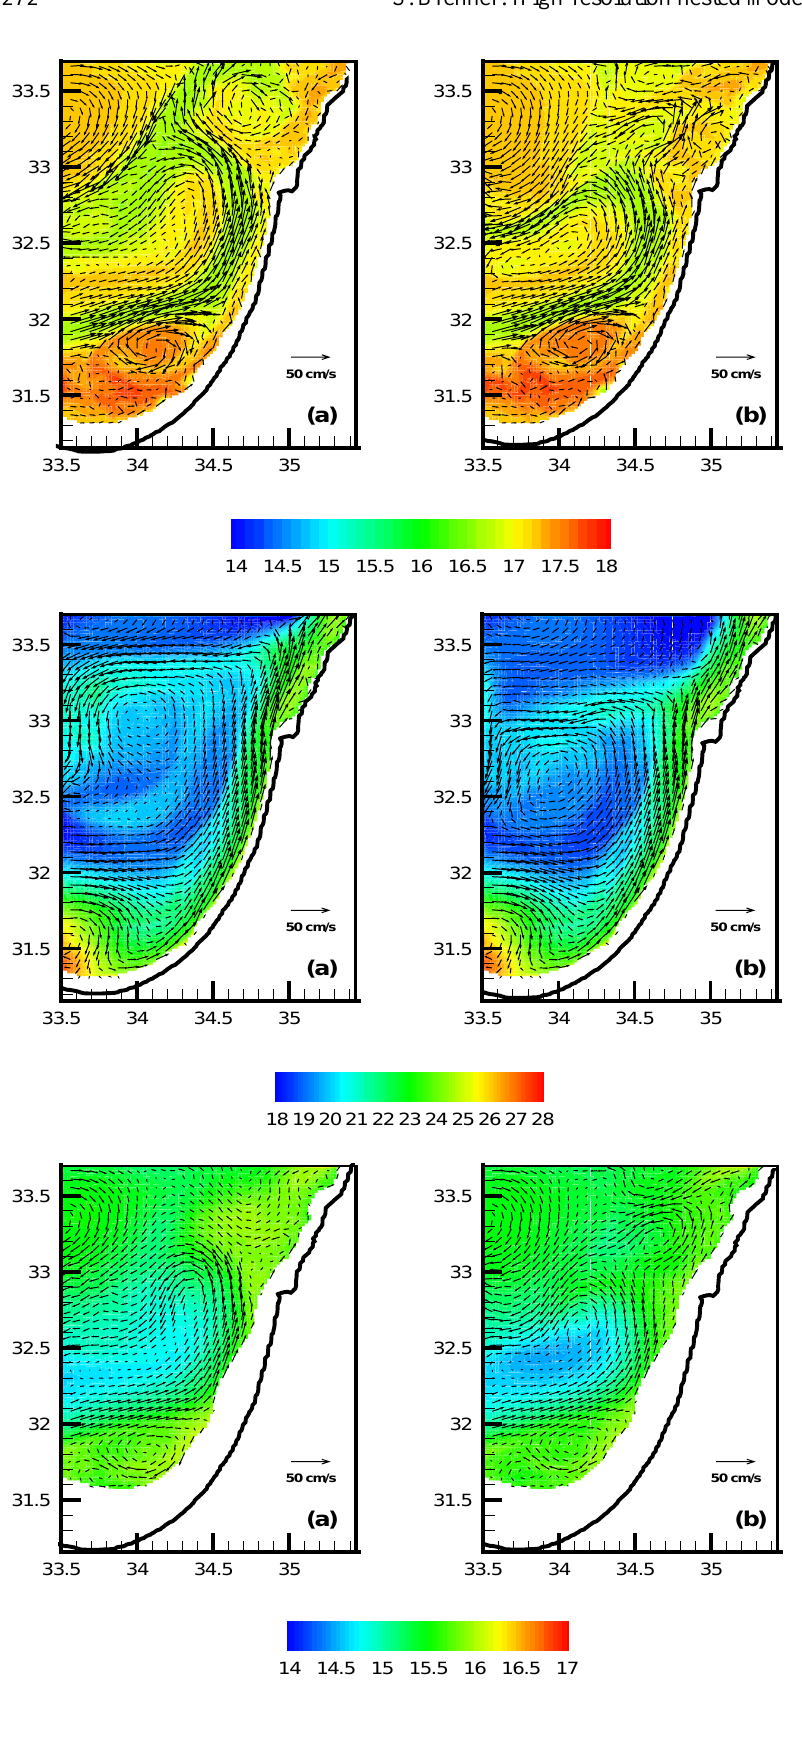
Fig. 5. Simulated potential temperature and velocity at 300m: (a) 20 February of the second year, (b) 20 February of the third